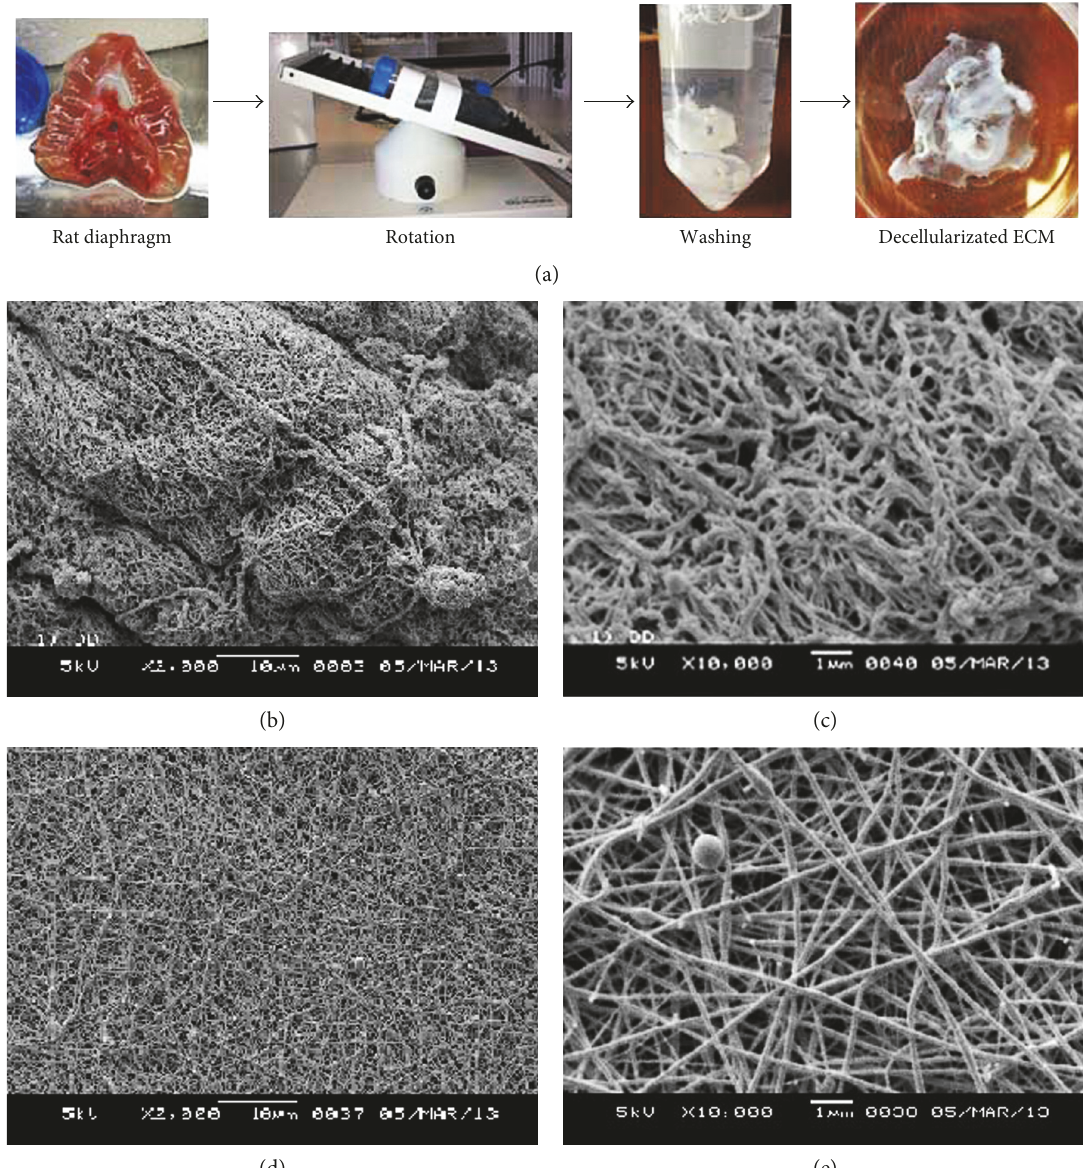
Figure 5: (a) A procedure of decellularization of rat diaphragm. (b, c) Results of TEM scan for the normal rat diaphragms. (d, e) Results of TEM scan for the decellularizated ECM sca ff olds of rat